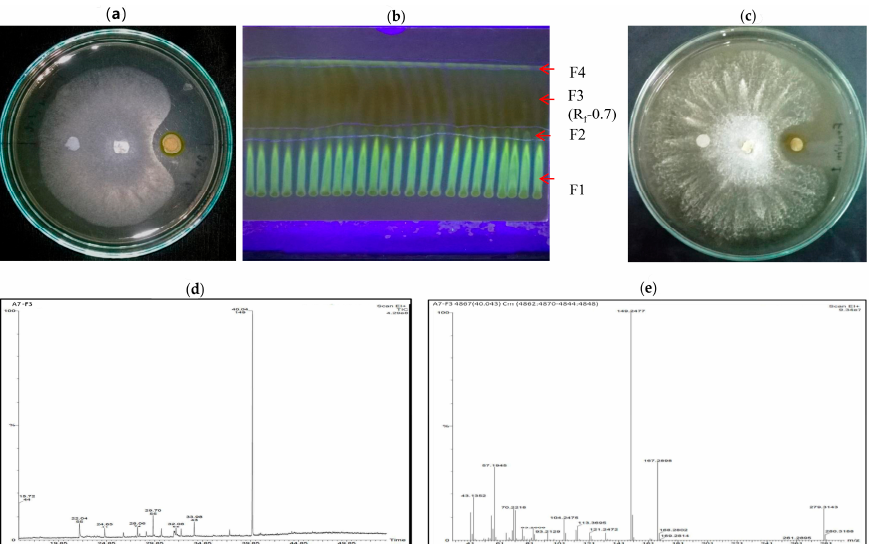
Figure 7. Bio-active compounds produced by the bacterial strain A7 in three biological replicates.